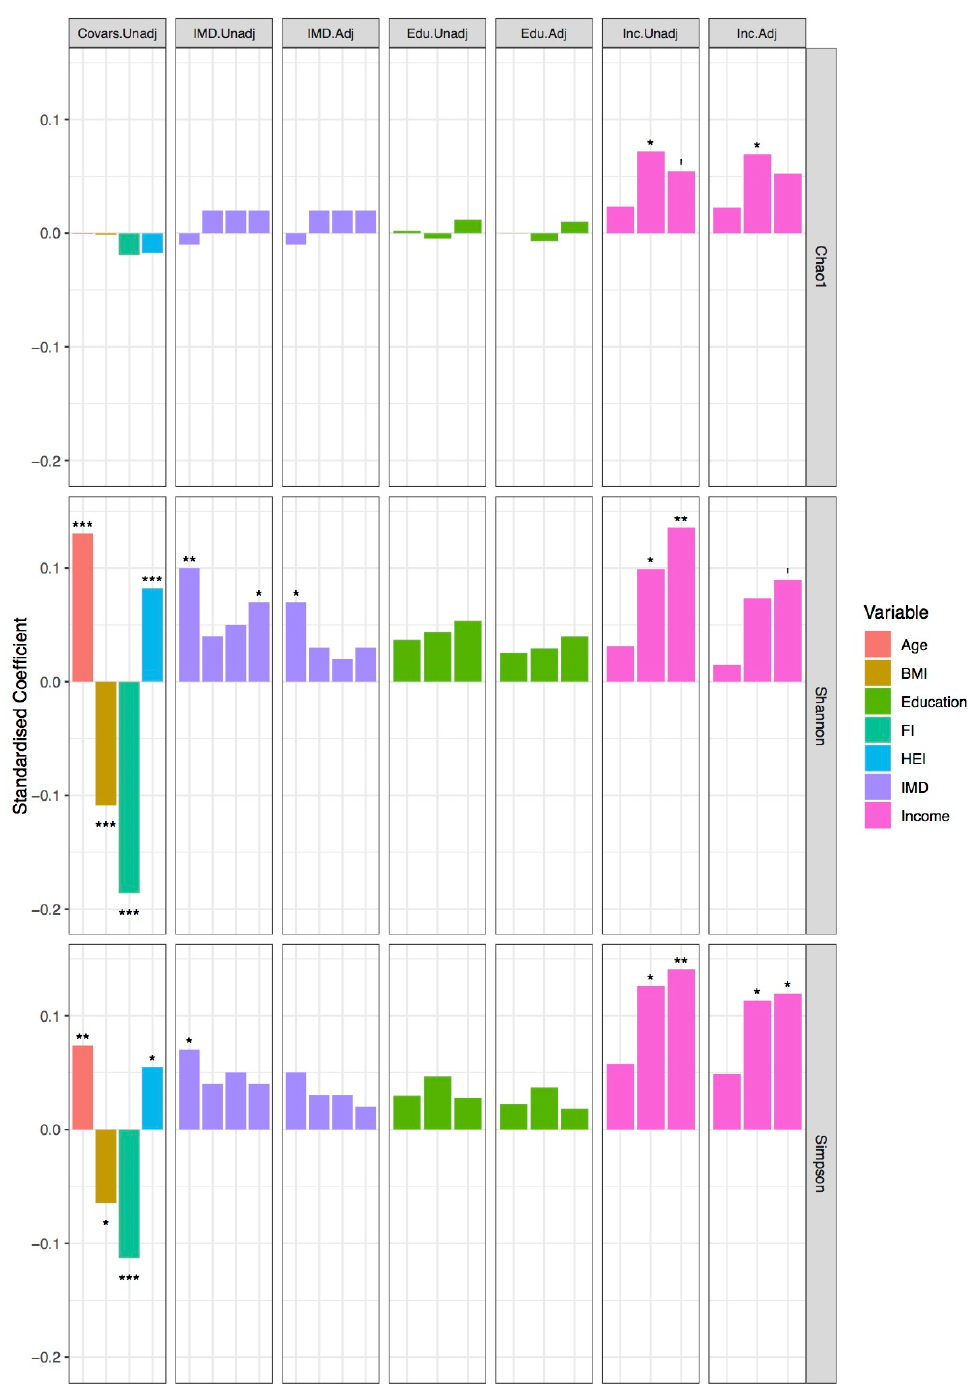
Figure 1. Alpha diversity and socioeconomic status. Bars represent the standardized coefficients extracted from hierarchical linear mixed effects models of alpha diversity (Chao1, Shannon diversity index, and Simpson’s diversity index): i. Covariate model, where model variables were age, Body Mass Index (BMI kg/m 2 ), health deficit (FI), and diet (HEI); ii. crude income model, iii. adjusted income model, iv. crude IMD model, and v. IMD-adjusted model. All models were adjusted for technical covariates modelled as random effects. Education models are not included due to non-significance. p -values indicated as: ‘ < 0.1, * < 0.05, ** < 0.01, *** < 0.001.